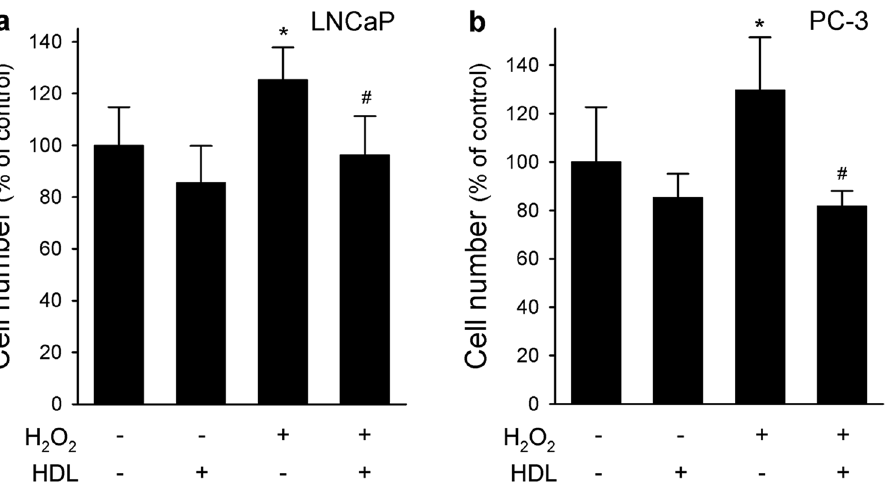
Figure 5. HDL inhibit cell proliferation induced by H 2 O 2 in LNCaP and PC-3 cell lines. LNCaP (Panel a) and PC-3 cells (Panel b) were incubated for 72 h with H 2 O 2 5 μ M, HDL 0.5 mg/ml or with a combination of both. Cells were then harvested and counted in a Burker chamber. Data are expressed as mean ± SD, n = 4. * P < 0.05 vs control, # P < 0.05 vs H 2 O 2 -stimulated